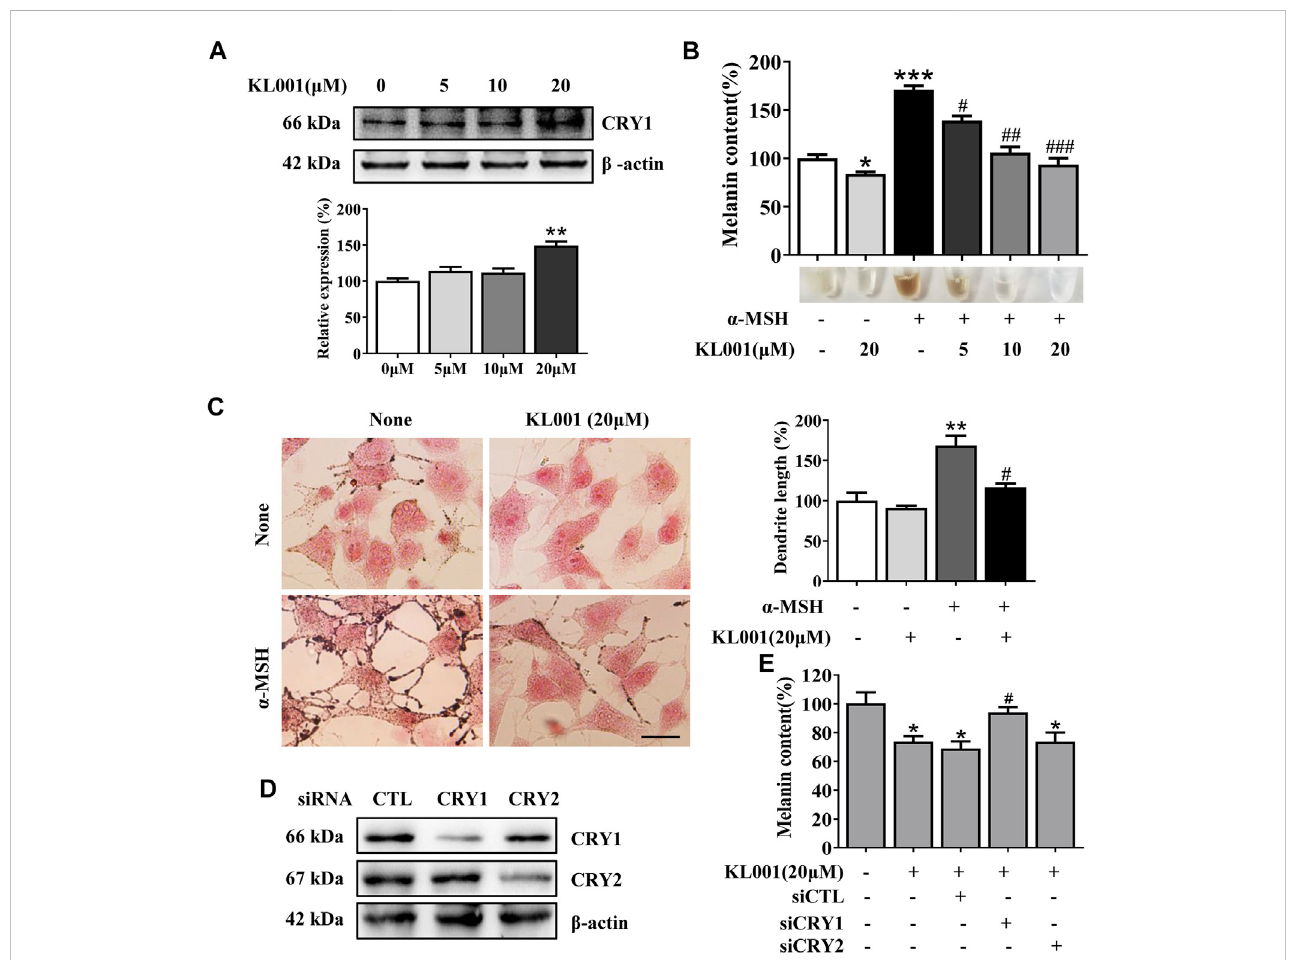
FIGURE 1 KL001 inhibited melanogenesis in B16F10 cells. (A) Western blot analysis to detect CRY1 protein levels were performed after treatment with KL001 for 48 h. (B) Melanin contents and (C) Fontana-Massonstainingphotograph are presented after treatmentwithKL001 inpresence orabsenceof α -MSH for 48 h. Bar = 20 μ m. Total length of dendrites per cell was measured on the pictures using ruler. (D, E) B16F10 cells were transfected with siRNA oligonucleotides using transfection reagent. WB analysis was performed after 48 h, and melanin contents were measured after 48 h in the presence of KL001. Data are expressed as the mean ± SD ( n = 3). * p < 0.05, ** p < 0.01, *** p < 0.001 versus non-treated cells. # p < 0.05, ## p < 0.01, ### p < 0.001 versus treated cells with indicated